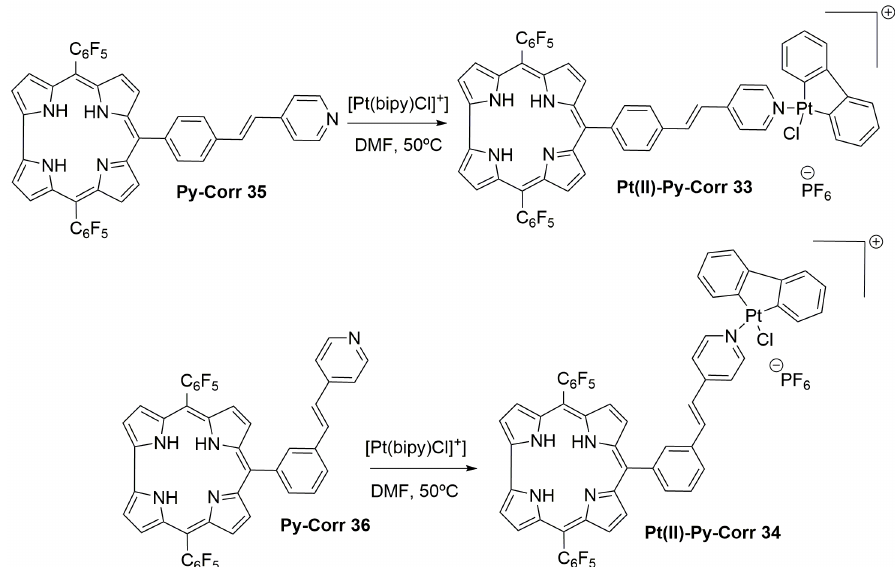
Figure 30 - Synthetic approach to bipyridyl platinum(II) corrole complexes Pt(II)-Py-Corr 33 and 34